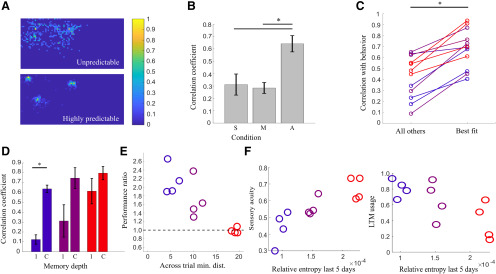
Modeling behavior as a Bayesian search with adaptive sensory acuity and memory depth explains performance under uncertainty. A, Examples of prior distributions accumulated over all trials for one predictable and one unpredictable set of pellet locations. Distributions have been normalized to their largest value (color bar). B, Correlation to animal performance of models with parameters emphasizing sensory (S) or memory (M) guidance or an adaptive model (A) individually fit to each animal. Horizontal lines indicate comparisons with significant differences between groups. C, Correlation of agent’s search performance with animal behavior when using parameters fit to other animals (all others) or the best fit to that specific animal (best fit). The best fit is significantly better than the fits from other animals (p = 0.0043, n = 12; significance indicated by horizontal line and asterisk). D, Correlation between animal behavior and a Bayesian search with either single trial memory (1) or best performance with cumulative memory (C). Significant difference is indicated by the horizontal line with an asterisk. E, Performance ratio (path length with priors from different distributions/path length with correct prior) for all animals plotted as a function of the across trial minimum distance for the distributions presented to each animal (significant correlation: R = −0.85, p = 0.0004). A higher value for the performance ratio indicates longer path length with a shuffled prior. Agents searching with unpredictable distributions (red) show identical performance regardless of the prior used. F, left, Sensory acuity based on the best fit search parameters versus RE based on the distributions that animals have experienced. Right, Long-term memory usage versus RE of pellet distributions encountered.